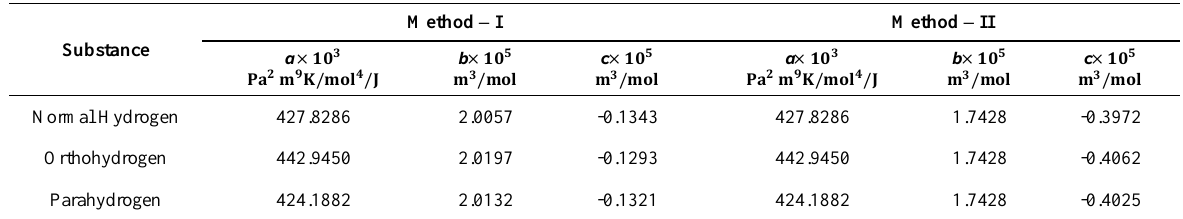
Table 1. Equation-of-state parameters by Methods – I, and II